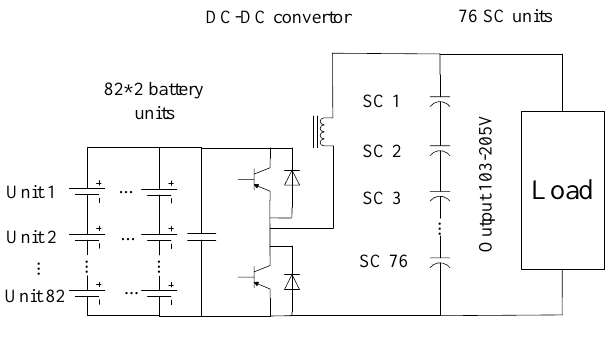
Figure 14. Configuration of the HESS.